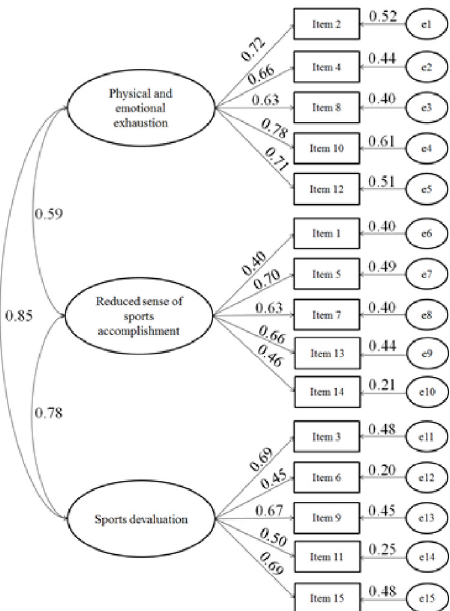
Figure 1 - Standardized coefficients of the Bootstrap replications, the correlation between factors and errors associated with each item of the modified model (M2) of the Brazilian version of the ABQ in a sample of youth and adult